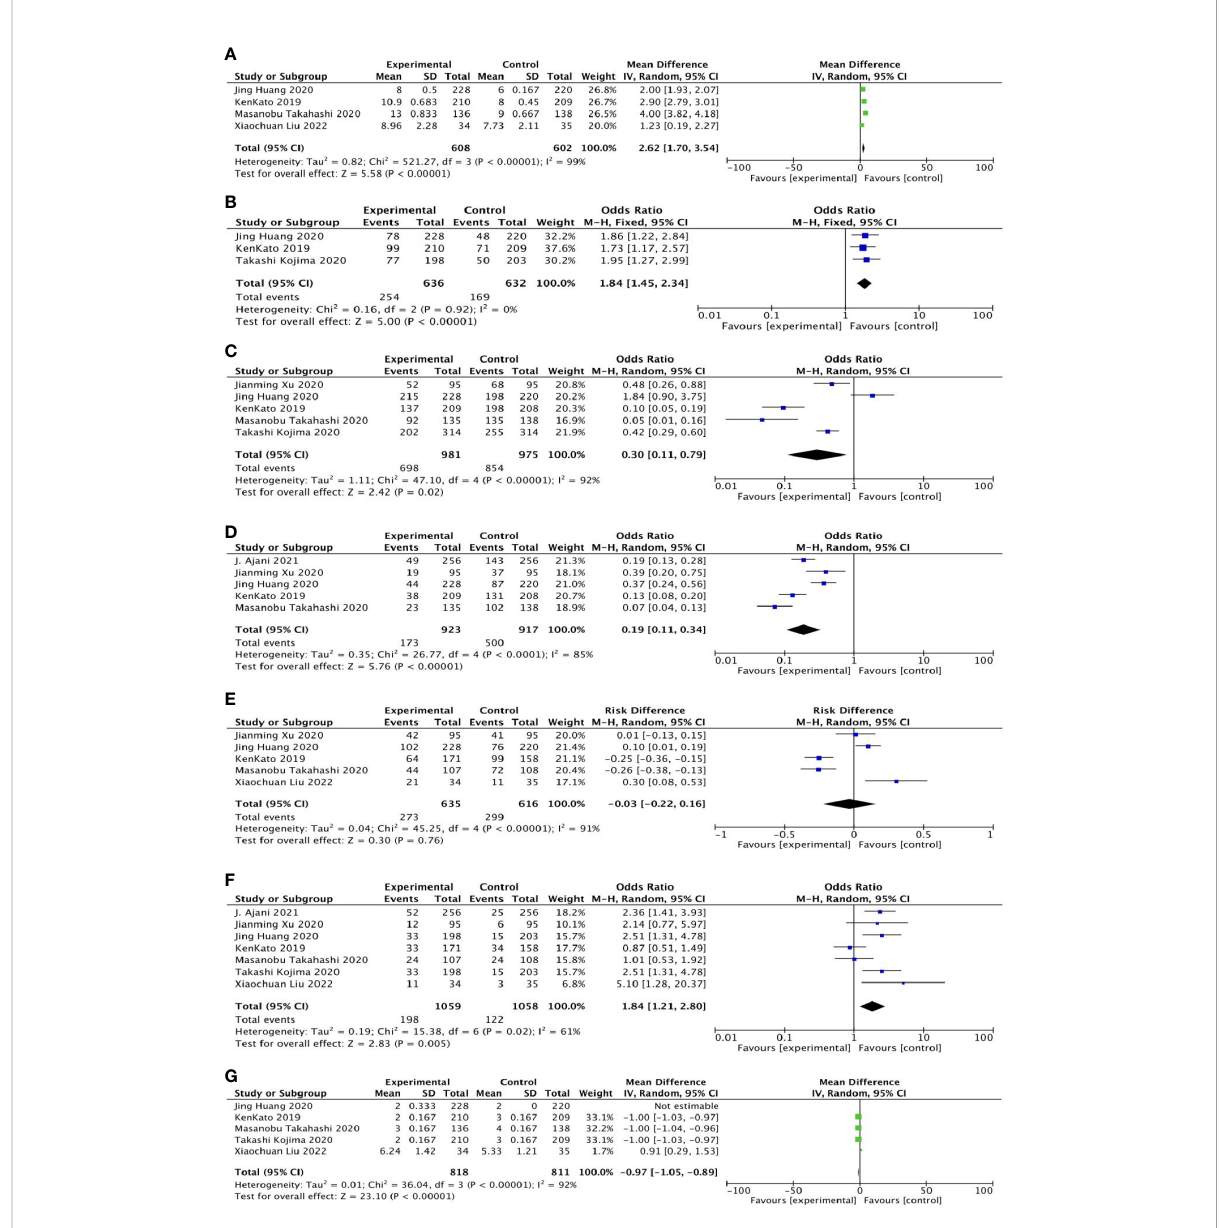
FIGURE 5 General forest plot for each outcome in second-line